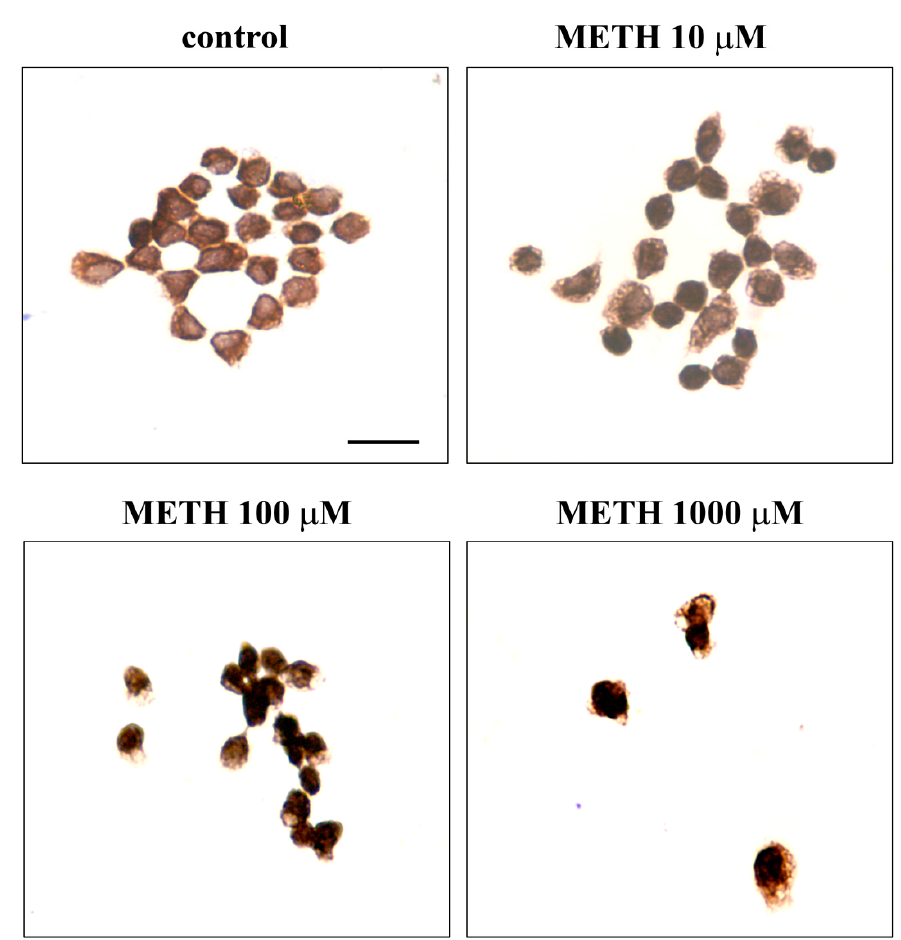
Figure 13. METH dose-dependently induces expression of α -synuclein. Representative immunocytochemistry for α -synuclein following METH. Scale bar = 19.2 μ M.